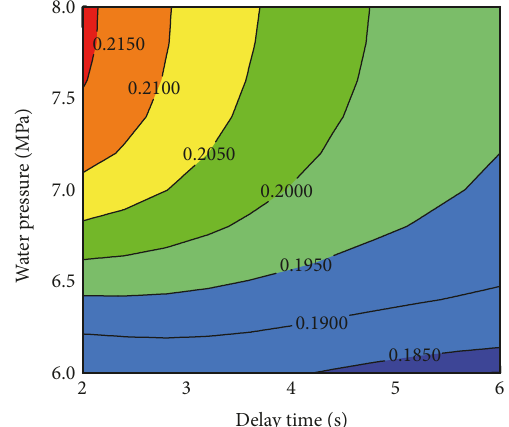
Figure 9: Comparison between experimental values and ANN predictions.